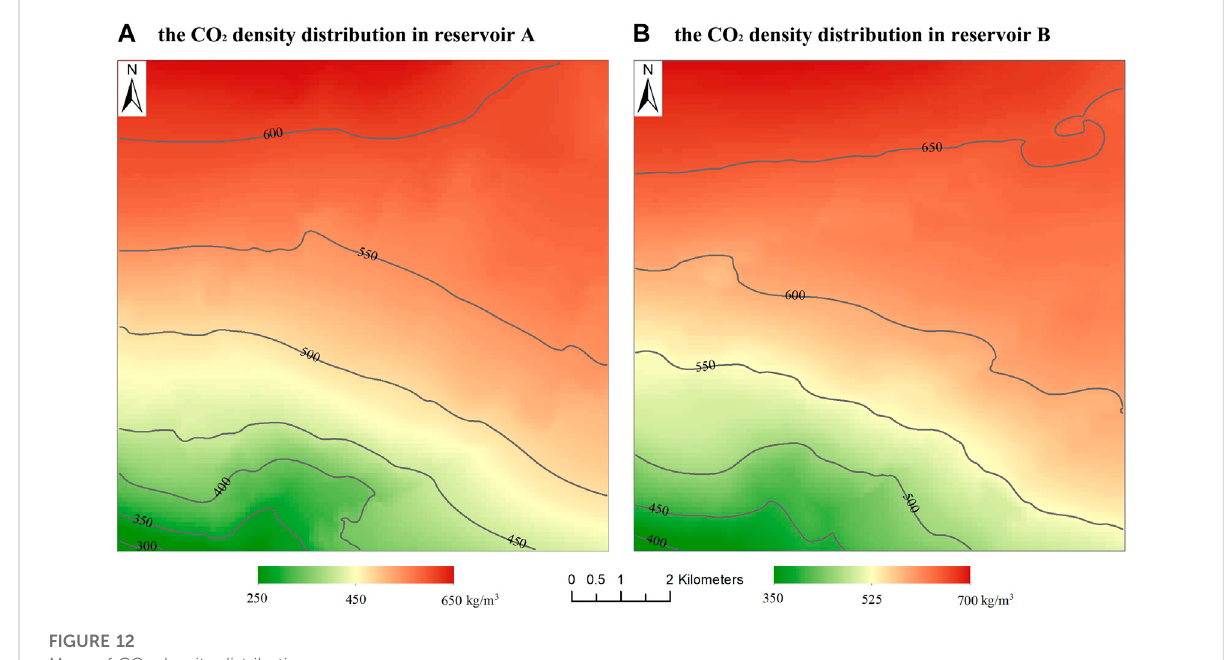
FIGURE 12 Maps of CO 2 density distribution.